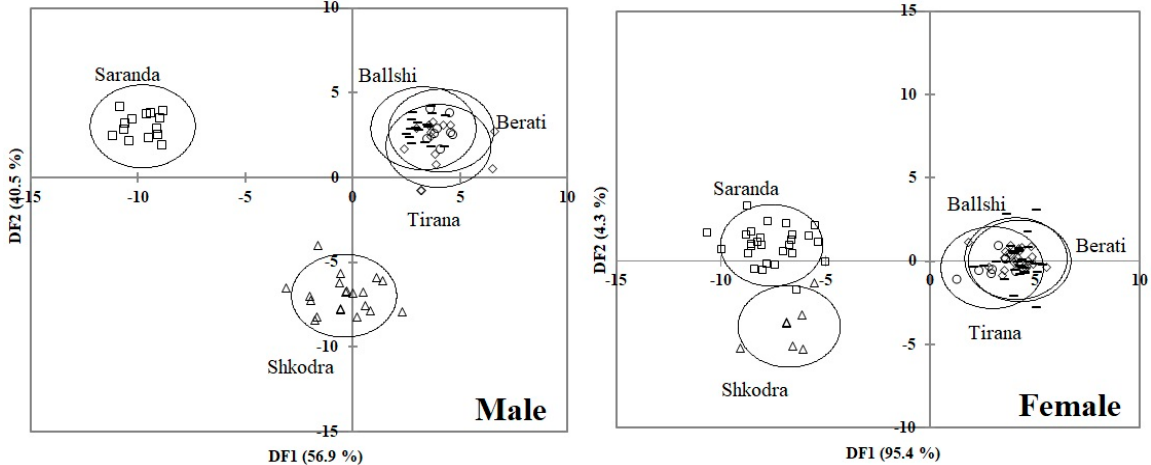
Figure 5. Discriminant function analysis plot with 95% confidence ellipses based on the morphological analysis by the male and female among the five regions in Albania.